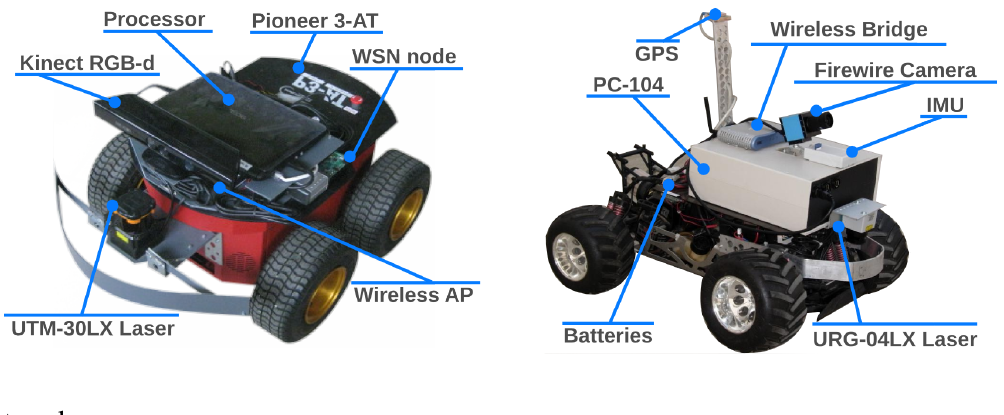
Figure 2. Robotic platforms and main onboard sensors used in the